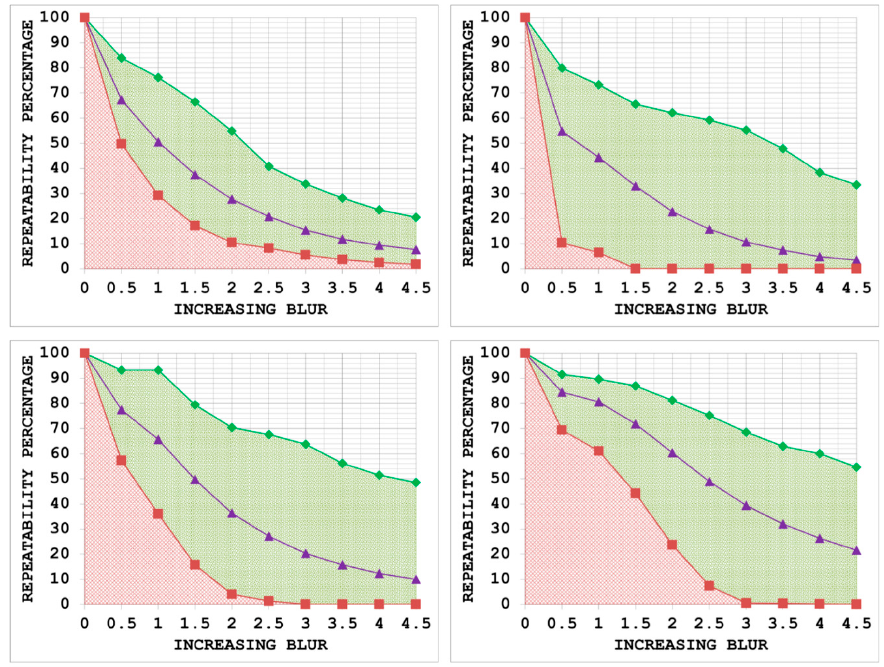
Figure 6. Results for blur changes utilizing the proposed framework and the image database for Salient ( top left ), EBR ( top right ), Harris-Affine ( bottom left ) and Hessian-Affine ( bottom right ) detectors.